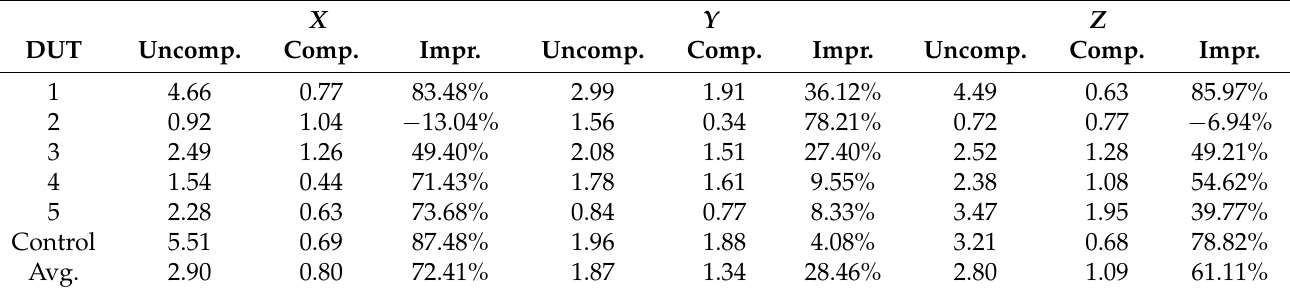
Table 6. Standard deviation of the samples during the verification test